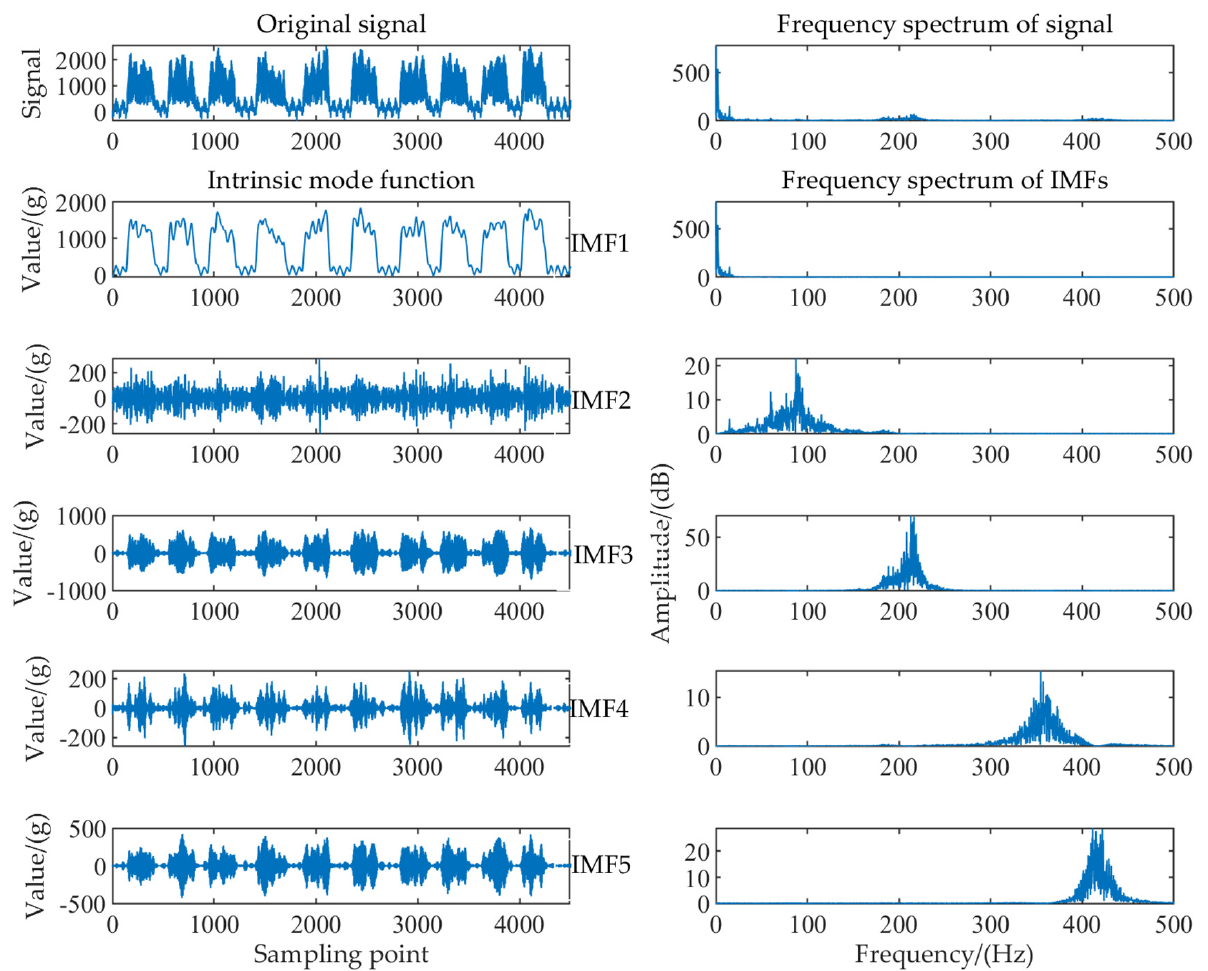
Figure 5. VMD decomposition results and spectrum analysis. Table 1. The main frequency of each IMF component.